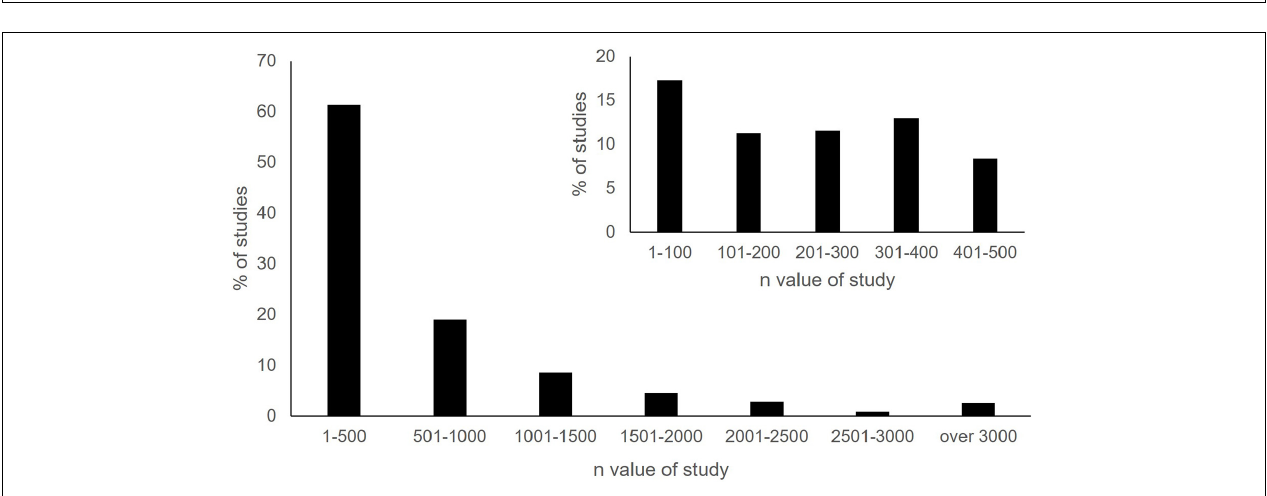
FIGURE 5 | Percent of ocean perceptions studies within each sample size category. Inset presents sample sizes for studies with fewer than 500 respondents ( n =